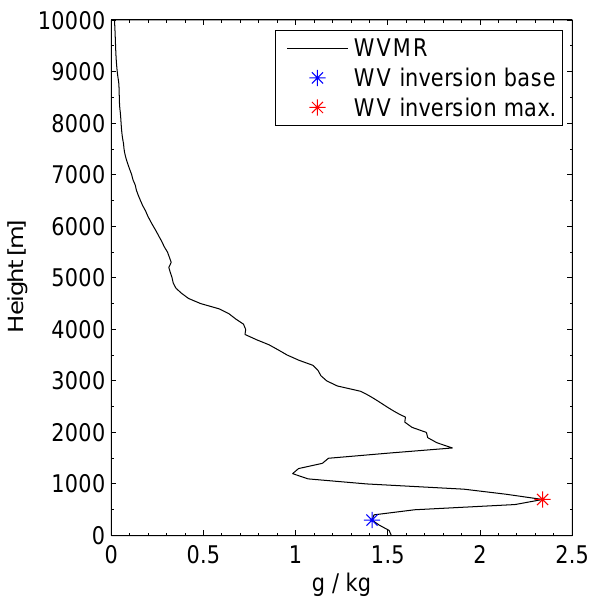
Fig. 2. Water-vapour mixing ratio profile from SHEBA on 18 April 1998 at 17:10 local time (line). Asterisks indicate the lo- cation of WV inversion-structure base (blue), and maximum MR (red). For profiles with multiple WV inversions, like shown here, only the inversion structure with the maximum absolute WV MR is examined and included in the